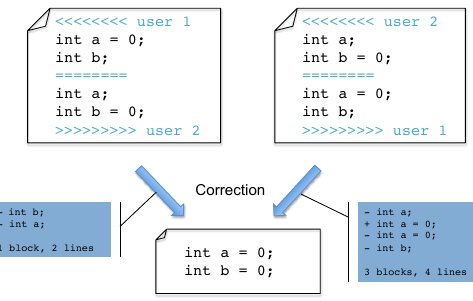
Figure 6. Computation of the